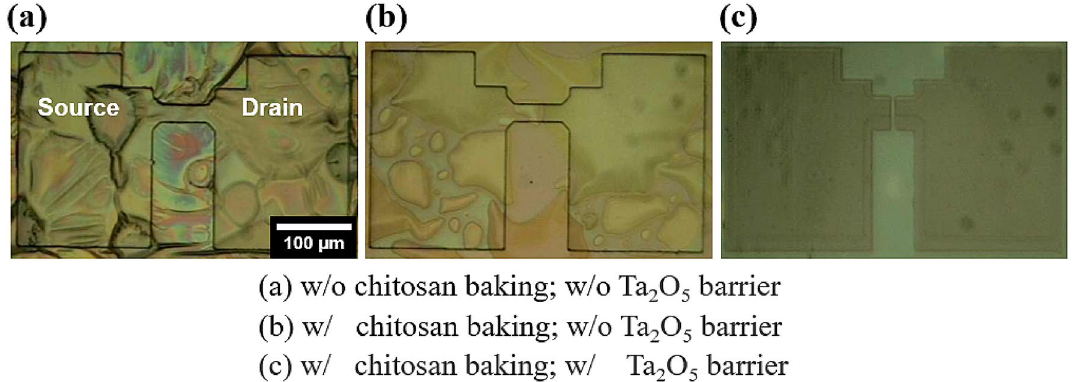
Figure 2. Optical microscopic images of the EDLTs fabricated by the lithography process. ( a ) Without chitosan baking and without the Ta 2 O 5 thin film. ( b ) With chitosan baking and without the Ta 2 O 5 thin film. ( c ) With chitosan baking and with the Ta 2 O 5 thin film. ( a ) and ( b ) show the deformed EDL, and ( c ) shows the normal EDL.